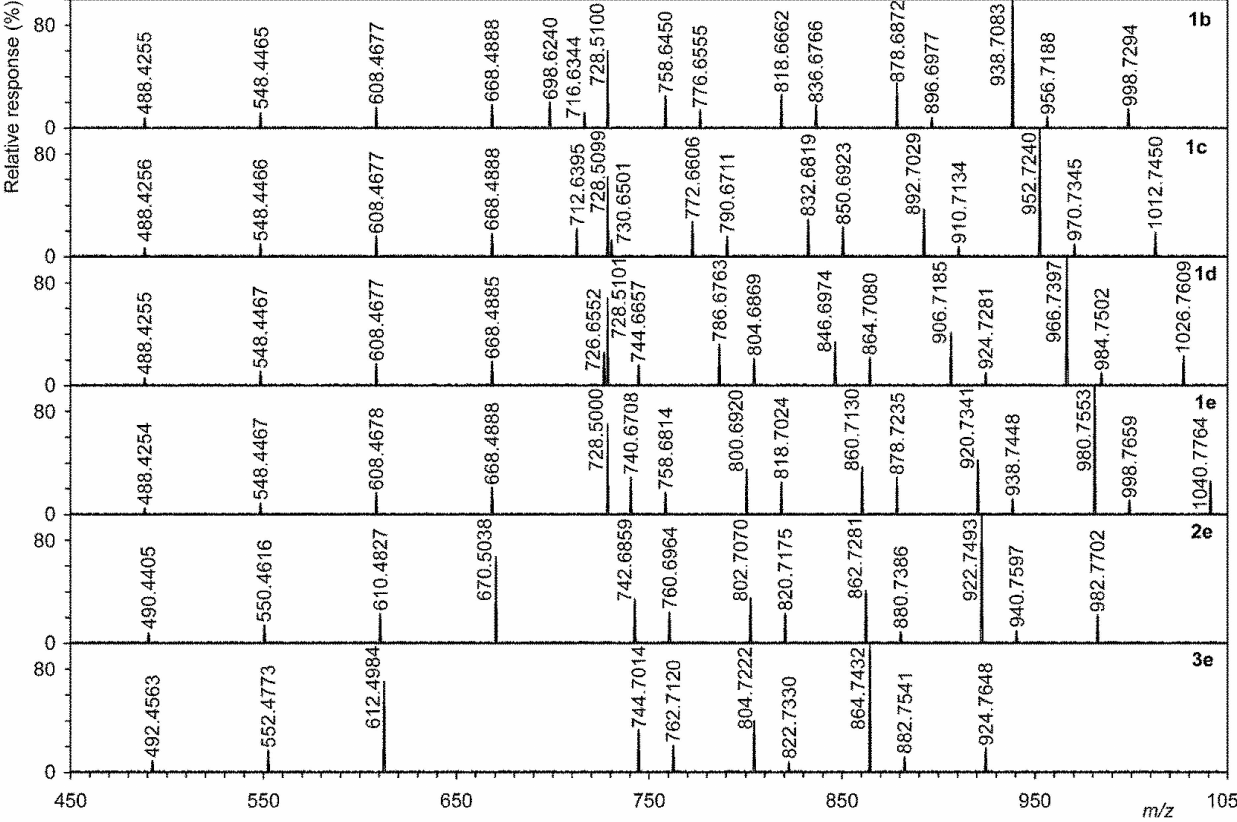
Figure 2. The major ions in the tandem MS spectra of compounds ( 1b–e , 2e , and 3e